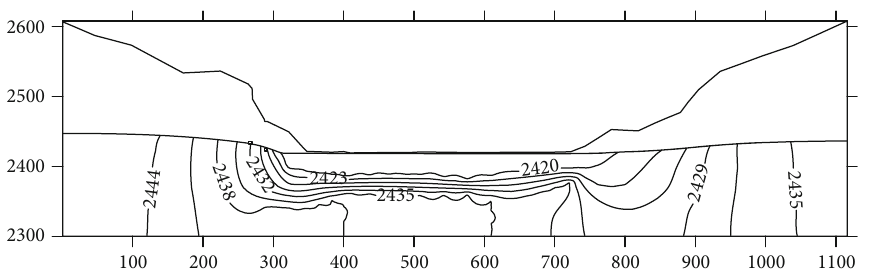
Figure 11: The isopotential distribution map of seepage fi eld about dam foundation (5-5 pro fi le).